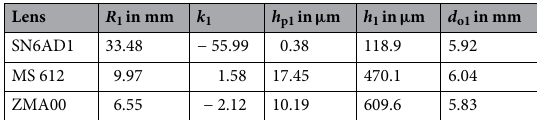
Table 1. Anterior surface geometry.